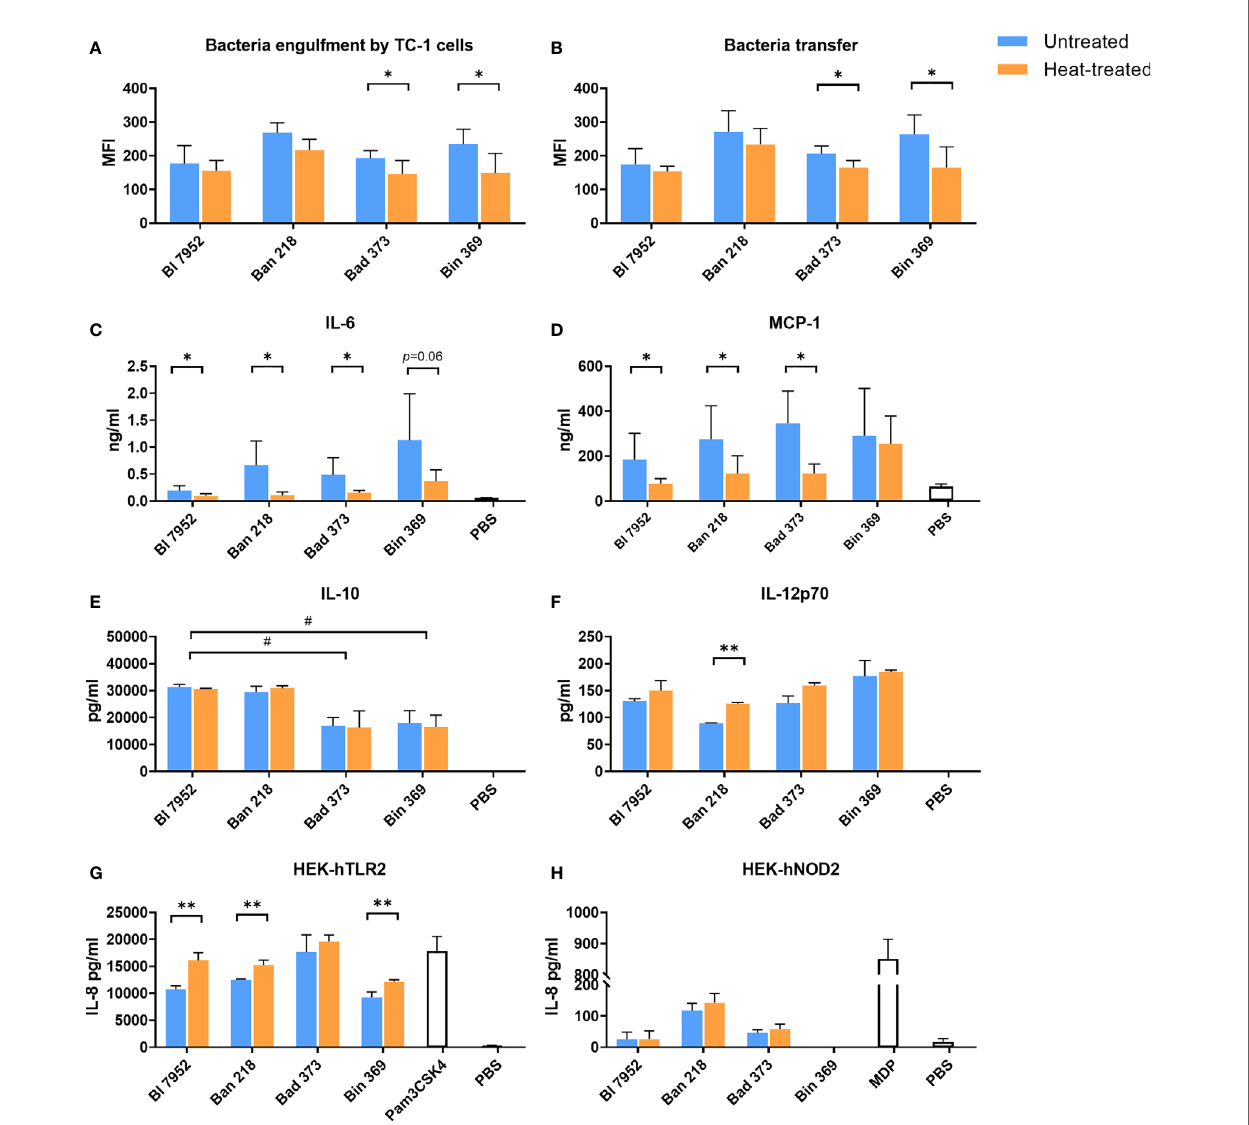
FIGURE 3 | Untreated and heat-treated bi fi dobacteria strains differently interact with epithelial and immune cells in vitro . (A) Engulfment by airway epithelial cells and (B) transfer between airway epithelial cells and dendritic cells of untreated (UN, blue bars) and heat-treated (HT, orange bars) bi fi dobacteria. Epithelial cells (TC-1 cells) were incubated overnight with SYTO ™ 9-stained bacteria cells. After washing of bacteria, epithelial cells were co-cultured with PKH26-stained JAWS II cells for 4 h. Fluorescence of double stained dendritic cells was analyzed by FACS and expressed as mean fl uorescence units (MFI). The level of (C) MCP-1 and (D) IL-6 cytokine production from TC-1 cells was measured by ELISA in culture supernatants after 24-h stimulation with bi fi dobacteria (UN or HT) or PBS. The level of (E) IL-10 and (F) IL-12p70 cytokine production was determined in supernatants of BMDCs after 20-h stimulation with UN or HT bi fi dobacteria or PBS. Activation of (G) TLR2 and (H) NOD2 receptors was determined using human embryonic kidney cells (HEK293) stably transfected with human TLR2 or NOD2 expressing vectors and expressed as production of IL-8 cytokine after 20-h stimulation by UN or HT bi fi dobacteria strains. TLR2 ligand Pam3CSK4 (1 µg/ml) and NOD2 ligand muramyl dipeptide (MDP; 100 ng/ml) were used as positive controls. Cells treated with PBS were used as negative control. Data are collected from three independent experiments. Data are shown as mean ± SD and analyzed with unpaired Student ’ s t-test between untreated and heat-treated bacteria. *p < 0.05, **p < 0.01 statistically signi fi cant difference. Comparison between bi fi dobacterial strains was calculated by one-way ANOVA Dunett ’ s multiple comparison test. # p <